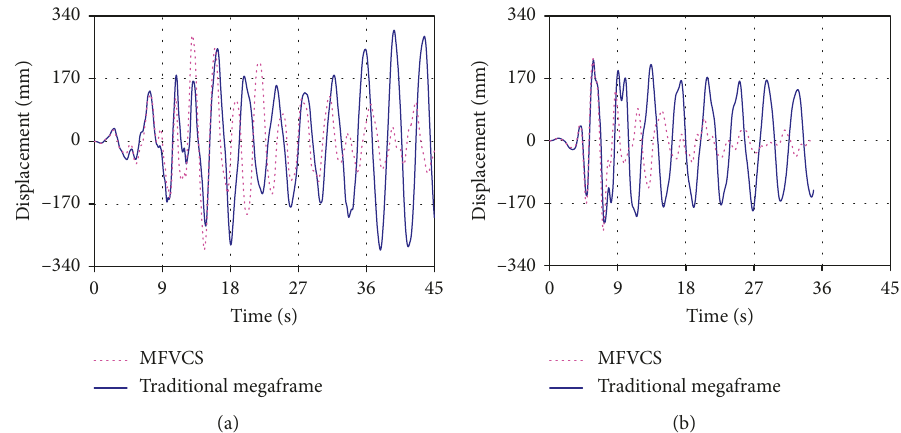
Figure 10: Comparison of time-history response of the top displacement between MFVCS and traditional megaframe under rare earthquake. (a) Manjil Iran (MANJIL/ABBAR--T) and (b) Loma Prieta